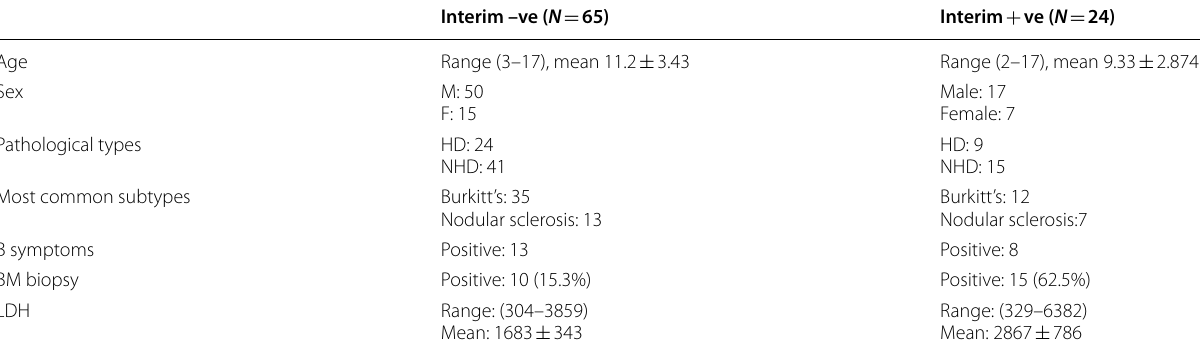
Table 2 Clinicopathological features of DS interim negative and positive groups